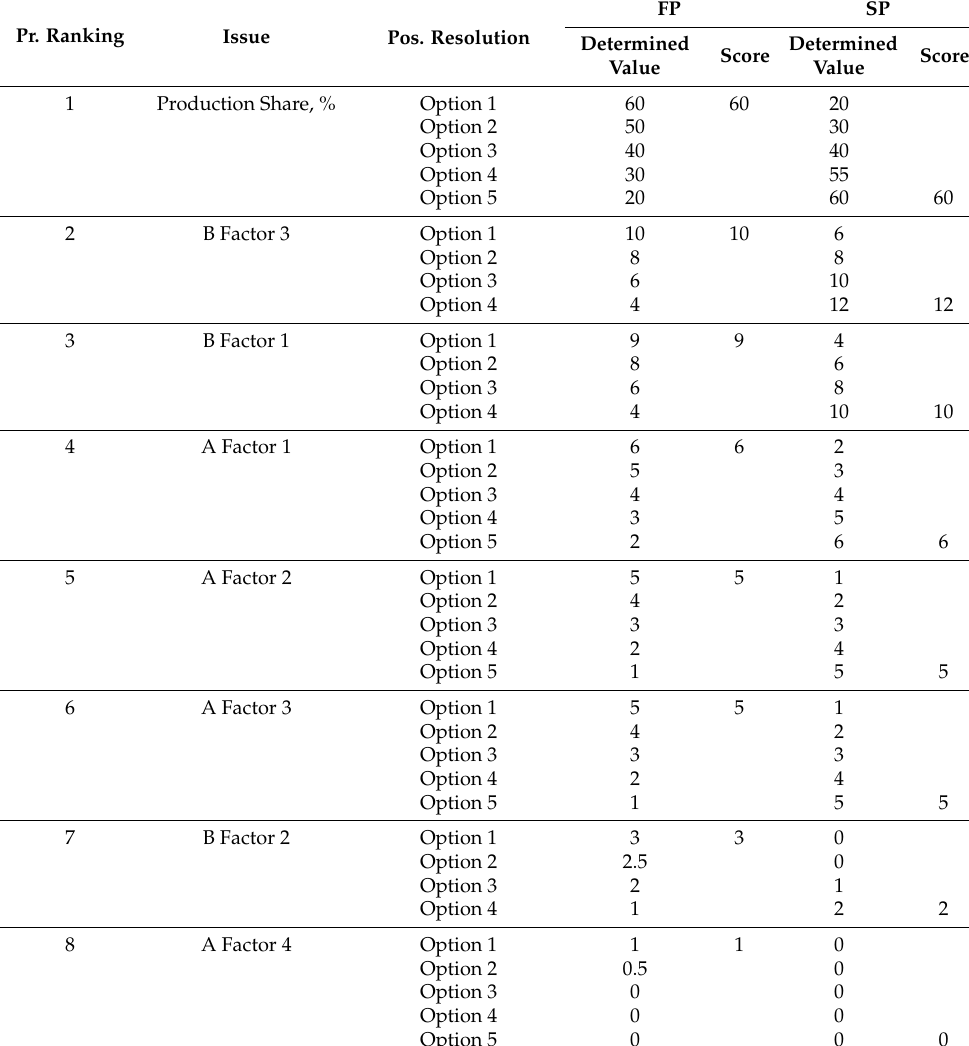
Table 6. Ranking issues by importance by the FP and SP. Pr.